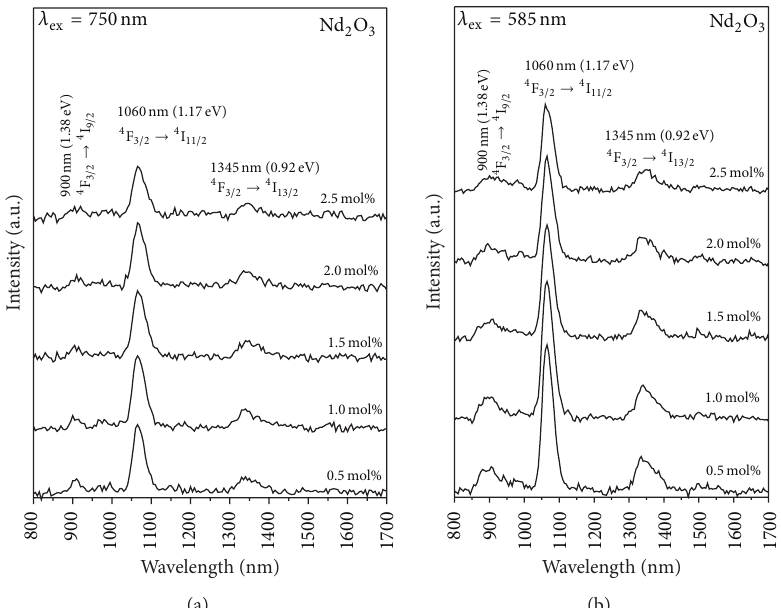
Figure 3: NIR luminescences spectra of Nd 3+ doped Bi 2 O 3 –BaO–B 2 O 3 glasses show downconversion at room temperature when excited by 585 and 750 nm excitation wavelengths.